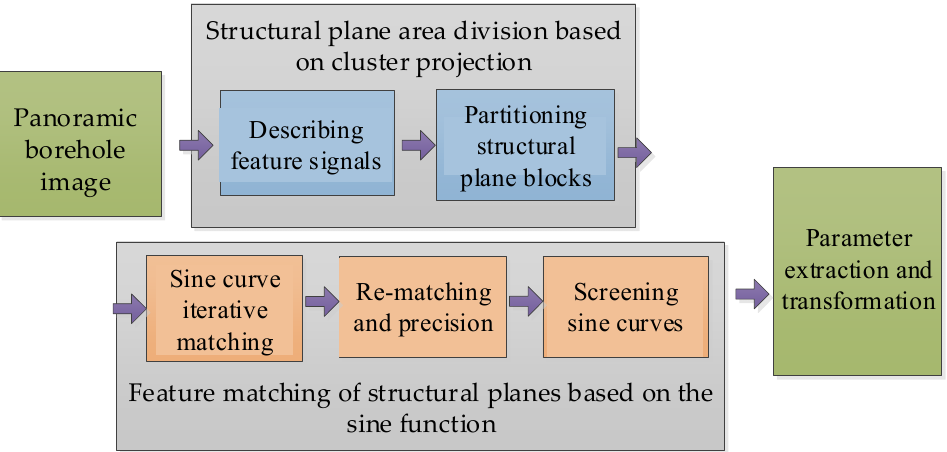
Figure 4. The main steps of the automatic recognition process to identify rock structures within a borehole.